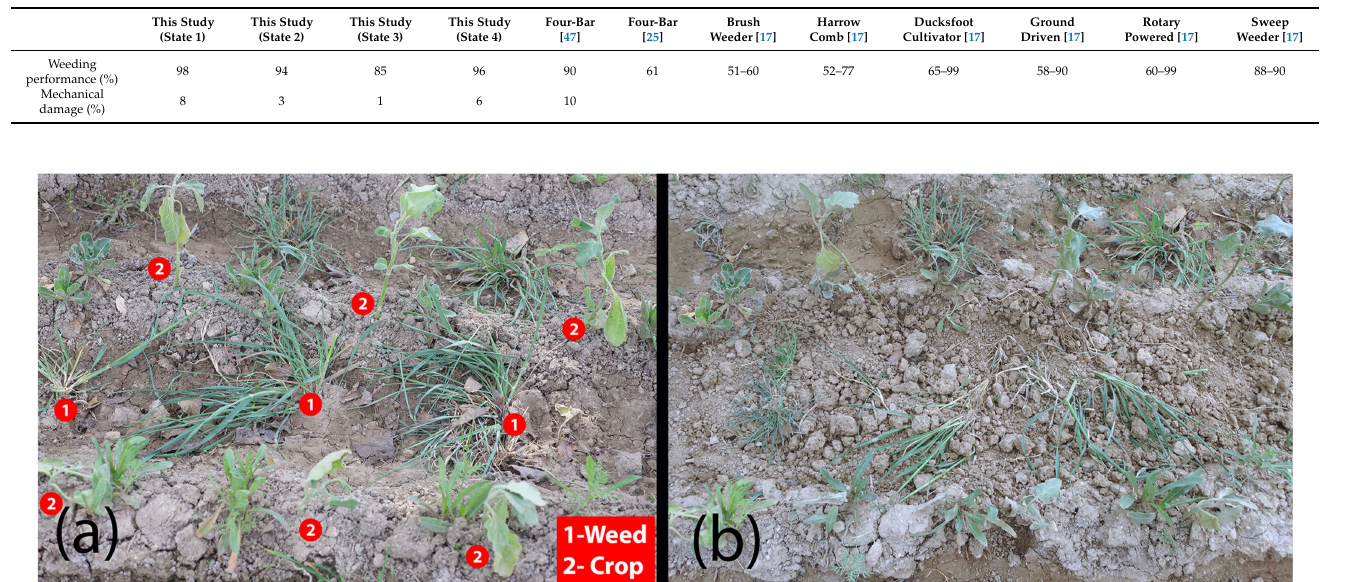
Table 6. Comparative results between proposed mechanism and other studies in terms of performance indicators.